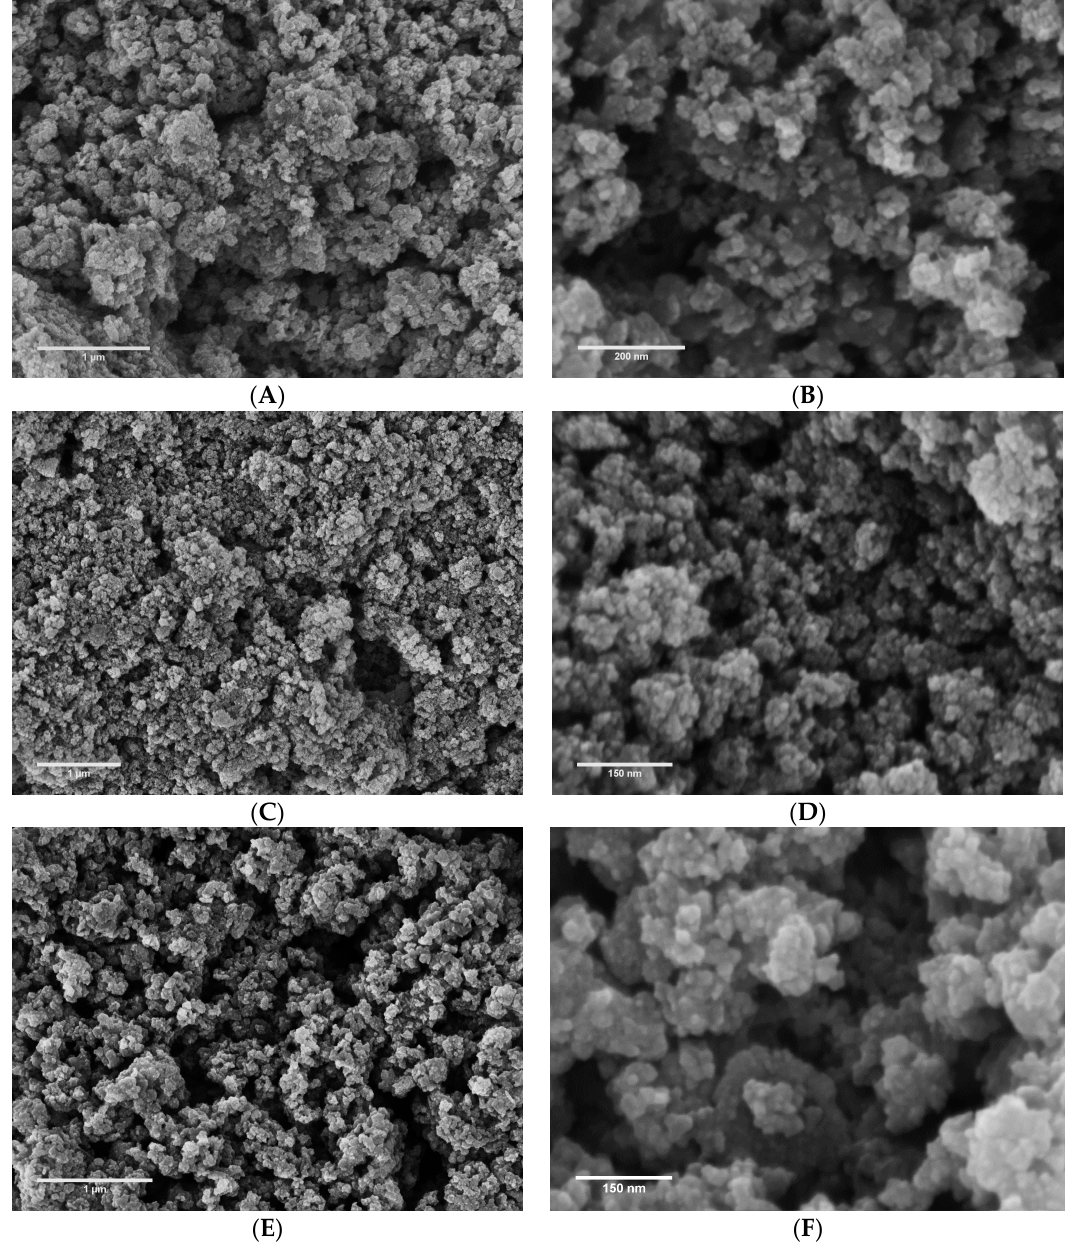
Figure 1. Scanning electron microscopy (SEM) images of Fe 3 O 4 /C/Mn hybrids: ( A , B ) from Fe 3 O 4 /C/Mn hybrid by redox method (Mn/MCS ‐ R); ( C , D ) from Fe 3 O 4 /C/Mn hybrid by impregnation method (Mn/MCS ‐ I); and ( E , F ) from Fe 3 O 4 /C/Mn hybrid by hydrothermal method (Mn/MCS ‐ H).